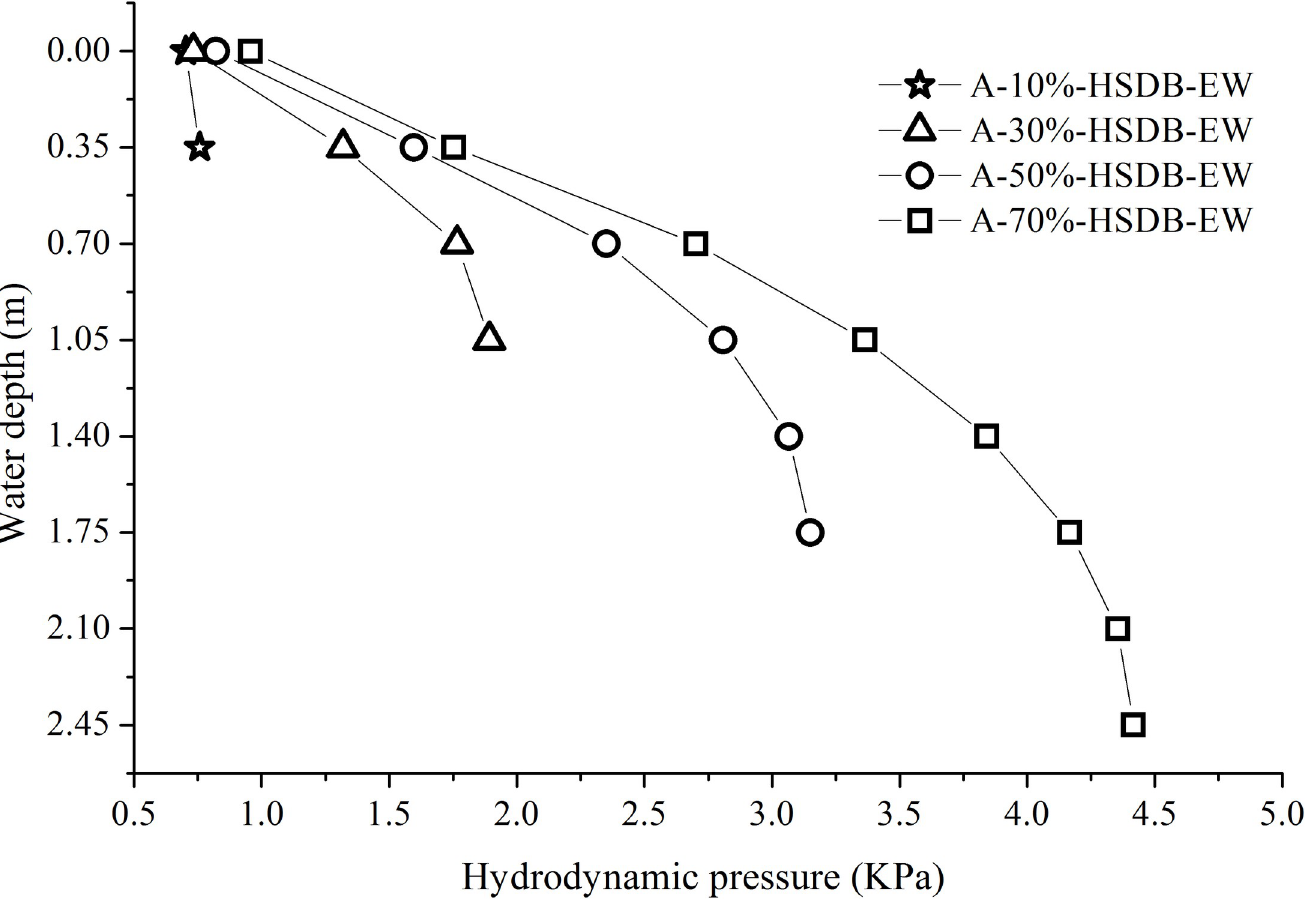
Fig 14. Maximum hydrodynamic pressure distributions of a tank wall at different water storage heights under the same ground motion input with 1.0 m/s 2 peak acceleration. a) HSDB-EW seismic motion. b) JZGYF-NS seismic motion. c) PJW-NS seismic motion. d) BJ-EW seismic motion. e) CC-NS seismic motion. f) YL-NS seismic motion. g) HX-NS seismic motion. h) EL-NS seismic motion. i) TJ-NS seismic motion.